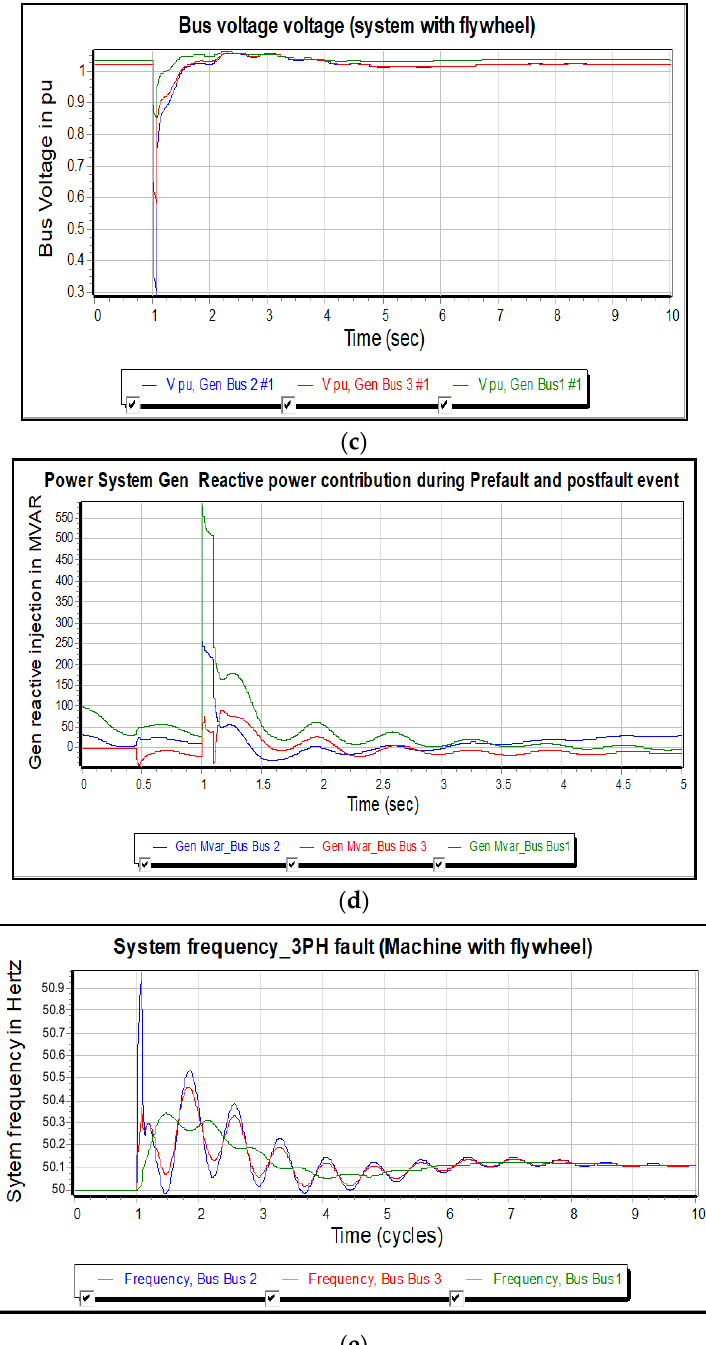
Figure 9. 3- ϕ fault simulation at 50% PV Penetration with flywheel: ( a ) generator rotor speed; ( b ) generator rotor angle stability graph; ( c ) system voltage recovery after a 3- ϕ fault; ( d ) reactive power contribution from considered power system; ( e ) response of considered system frequency after oc- currence of 3- ϕ fault .